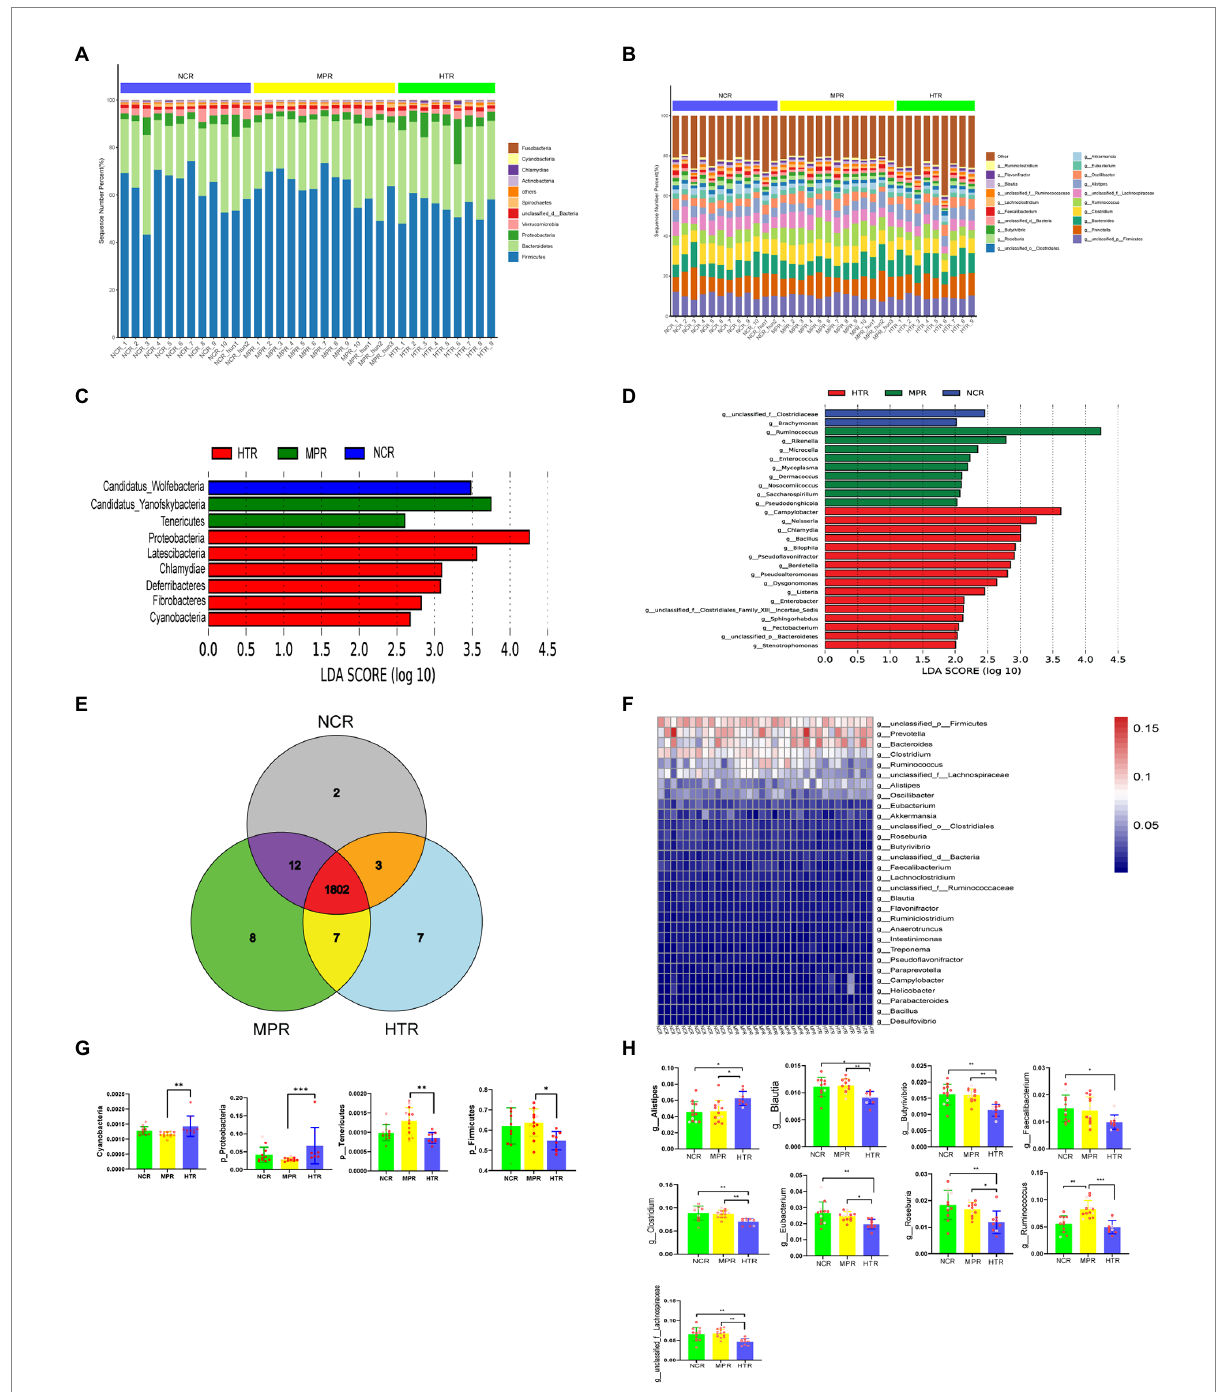
FIGURE 2 (A) Abundance of the top 10 gut bacteria phyla. (B) Abundance of the top 20 gut bacteria genera. Linear discriminant analysis effect size (LEfSe) showing the significantly different taxa between the study sites at the (C) phylum and (D) genus levels ( LDA scores > 3.0, p < 0.05). NCR, non- contaminated region; MPR, medical pollution region; HTR, heavy-tourist traffic region. (E) Genus distribution between the three study sites. (F) Heatmap showing the relative bacterial abundance at the genus level. Comparison of the relative abundance of gut microbiota between the three study sites at the (G) phylum and (H) genus levels across top 20 bacteria. * p < 0.05; ** p < 0.01; *** p <